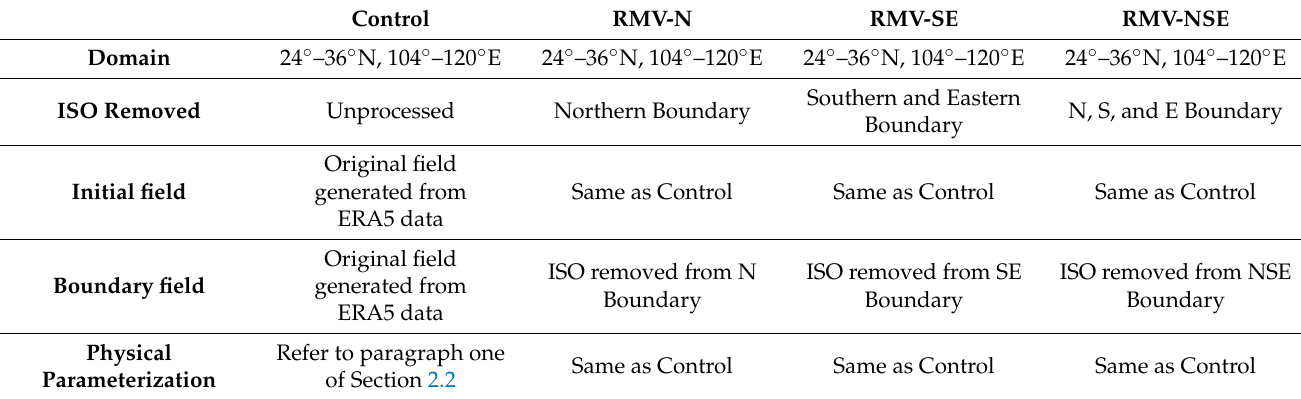
Table 2. Details of the PLF